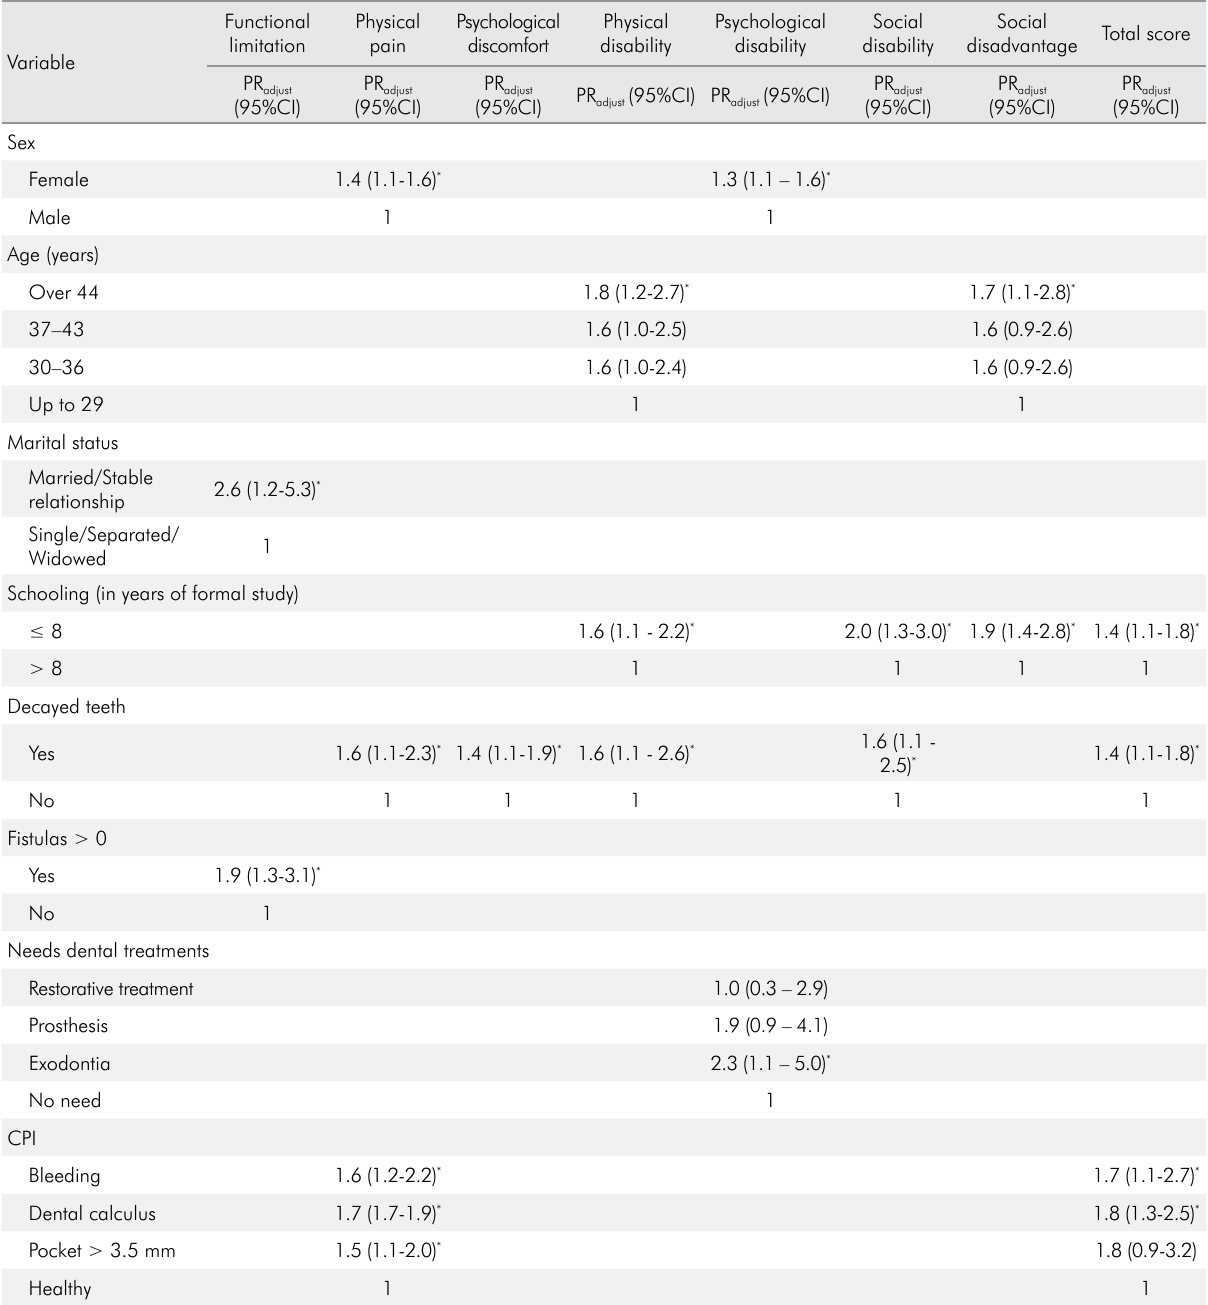
Table 3. Multiple analysis between domains and total score of the OHIP-14 with sociodemographic and oral health variables (n = 176).